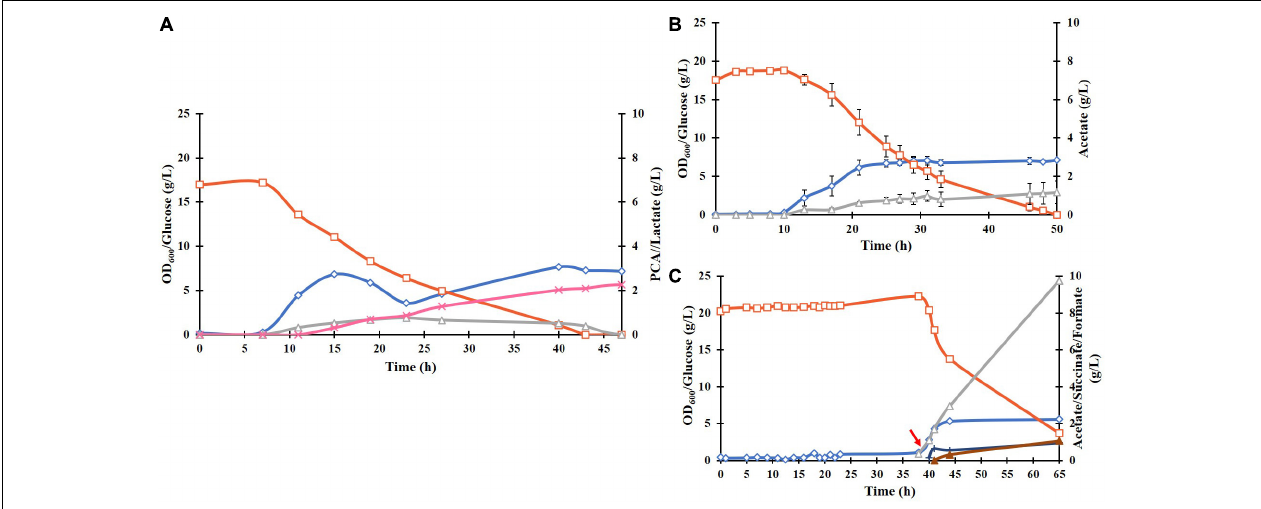
FIGURE 5 | Effect of trace metal concentration and PCA on cell growth and production of metabolites by E. coli ATCC 31882-DSD in the modified M9 medium: (A) supplemented with four times higher trace metal concentration and induction at 0 h with 0.1 mM IPTG, (B) non-induced culture with four times higher trace metal concentration, (C) culture as in B and with addition of PCA at 40 h of cultivation. The symbols denote the profiles of cell density measured as OD 600 ( ♦ ), concentrations of glucose ( (cid:3) ), PCA (x), acetate ( (cid:52) ), succinate ( (cid:78) ), and formate ( + ).